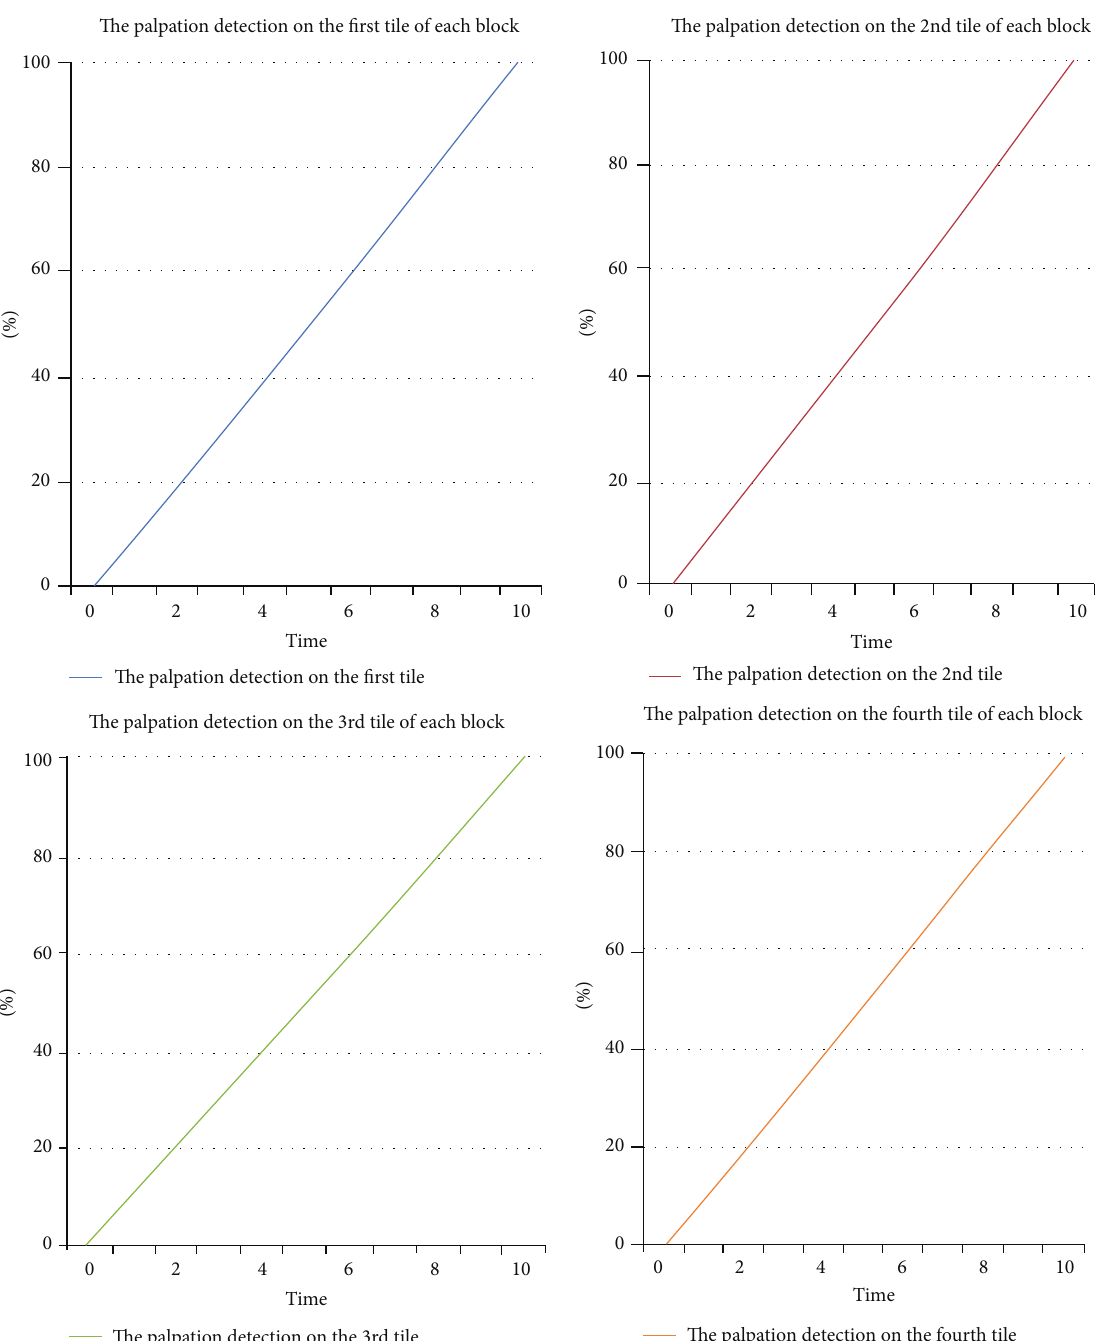
Figure 8: The palpation detection on the tiles of a